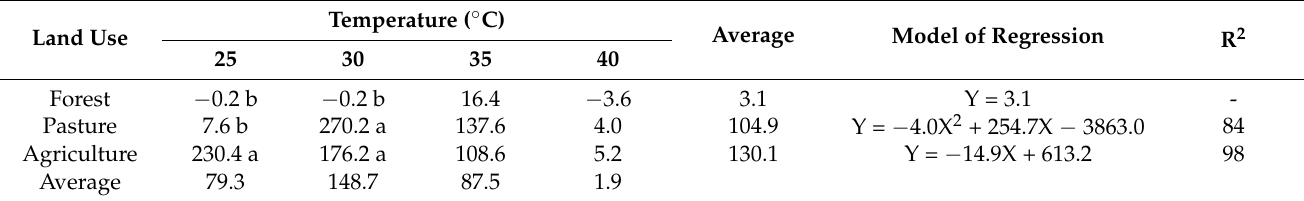
Table 2. Total N 2 O emissions ( µ g N 2 O g − 1 dry soil) in different land-use systems, subjected to temperature levels.